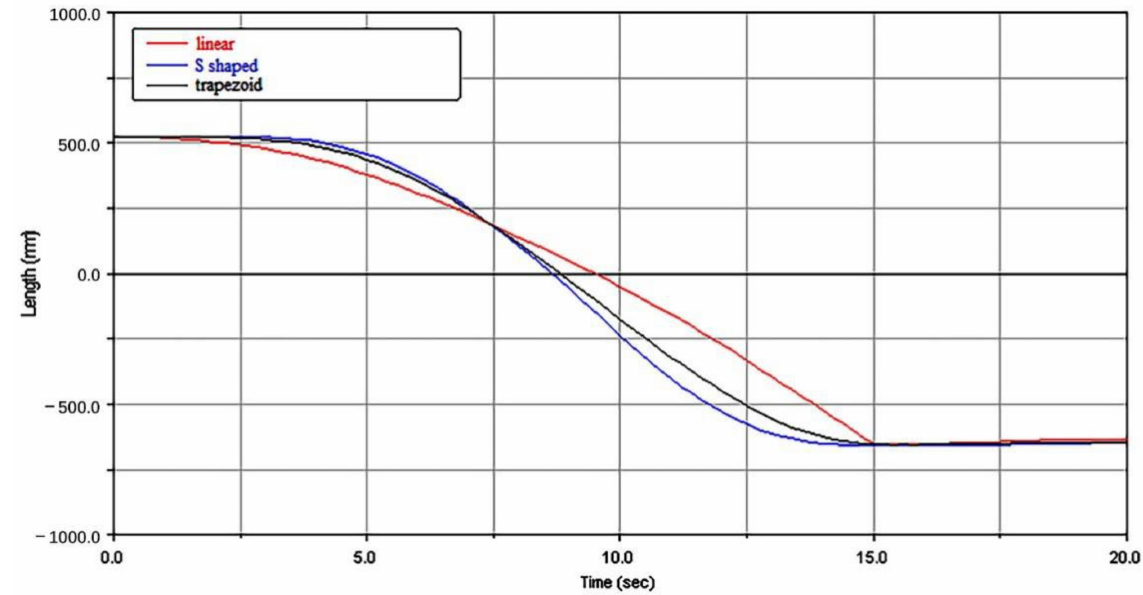
Figure 9. Displacement distribution in different drive